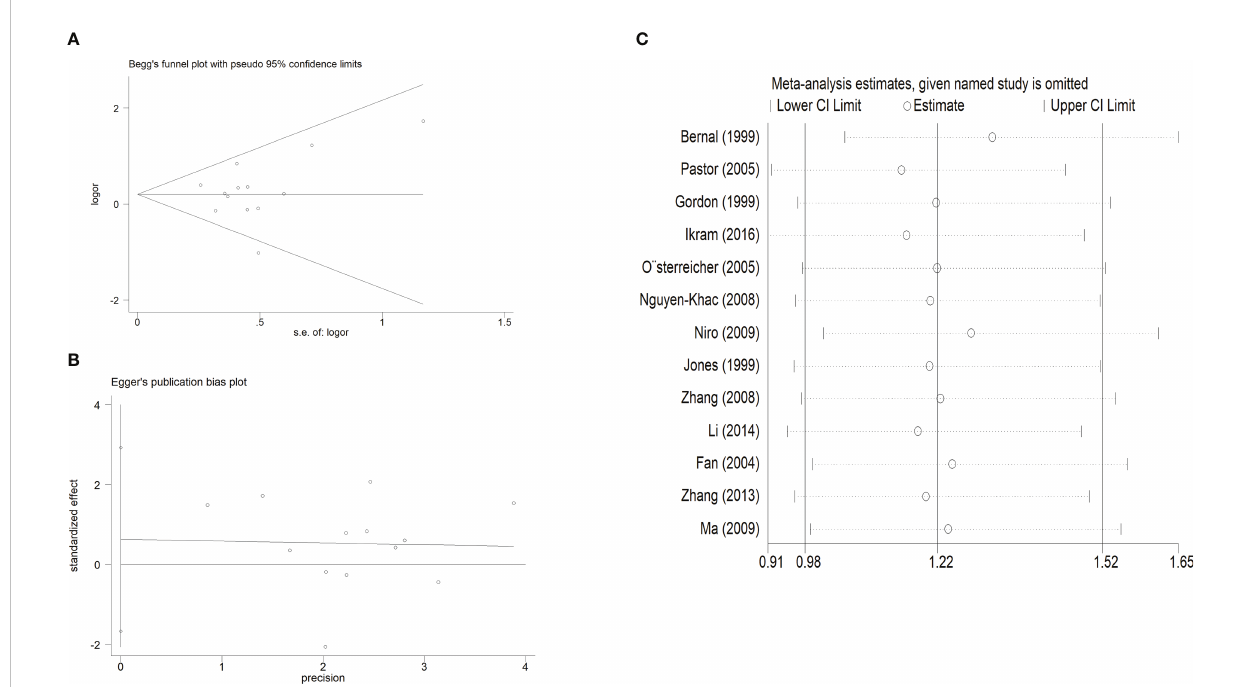
FIGURE 6 (A) . Begg ’ s funnel plot test for publication bias, with individual points corresponding to speci fi c studies, and the mean effect size being represented by the horizontal axis. Log [OR], natural logaritm of OR. (B) . Egger ’ s publication bias plot. (C) : Sensitivity analysis for the association between TNF- a rs361525 polymorphisms and LC